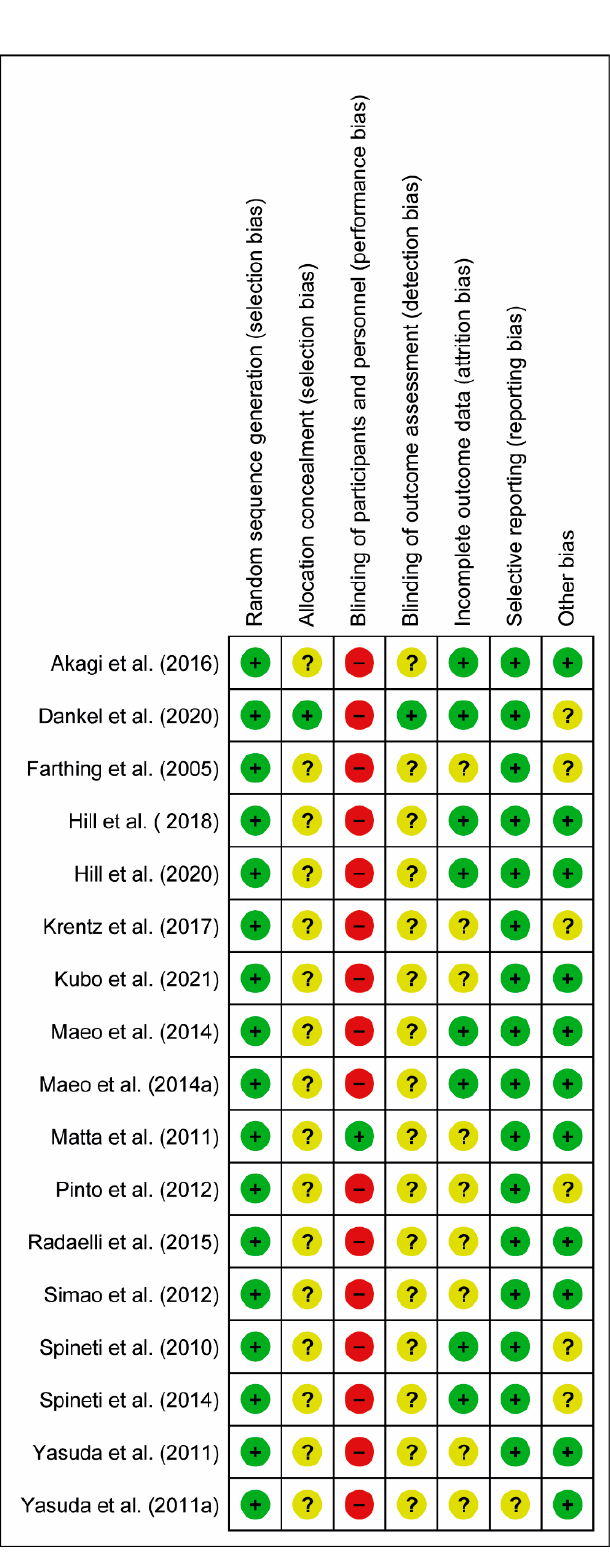
Figure 2. Risk of bias summary: review authors’ judgements about each risk of bias item for each included study. References for the studies in the table with the same publication year are Maeo et al. (2014) [83], Maeo et al. (2014a) [84], Yasuda et al. (2011) [91] and Yasuda et al. (2011a) [92].